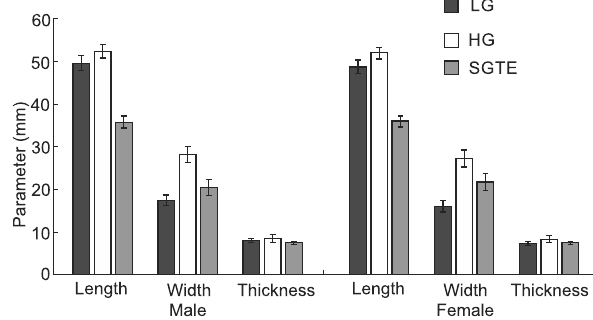
Figure 5. Morphometric parameters (mm) of the HG, LG and SGTE in European bison. (HG) Harderian gland, (LG) lacrimal gland, (SGTE) superficial gland of the third eyelid. Values are expressed as mean ± standard